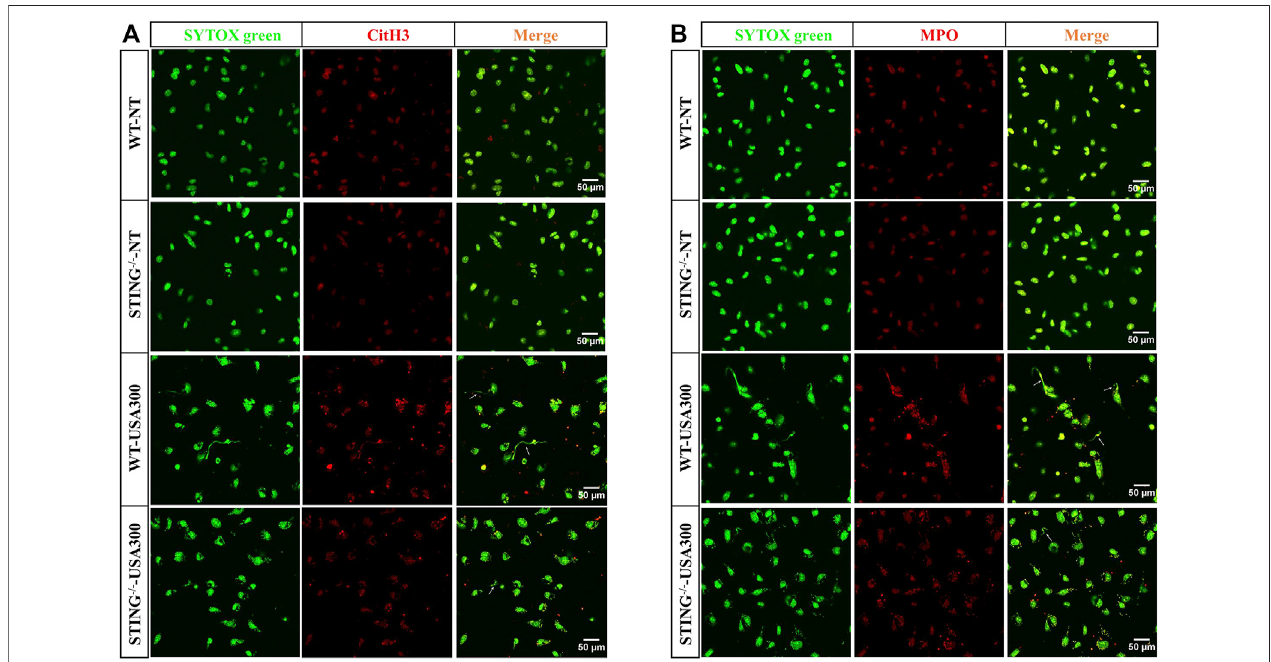
FIGURE 2 | STING -/ − BMDMs present decreased colocalization of DNA decorated with CitH3 and MPO in S. aureus -induced ETs structures. WT and STING -/- BMDMswere infected with S. aureus (MOI: 20) for 3 h and then fi xed with 4%paraformaldehyde. DNA decorated withCitH3 (A) and MPO (B) within ETswere detected using a scanning confocal microscope. DNA was stained with SYTOX green. METs structures were marked with white arrows. The experiments were repeated 3 independent times.